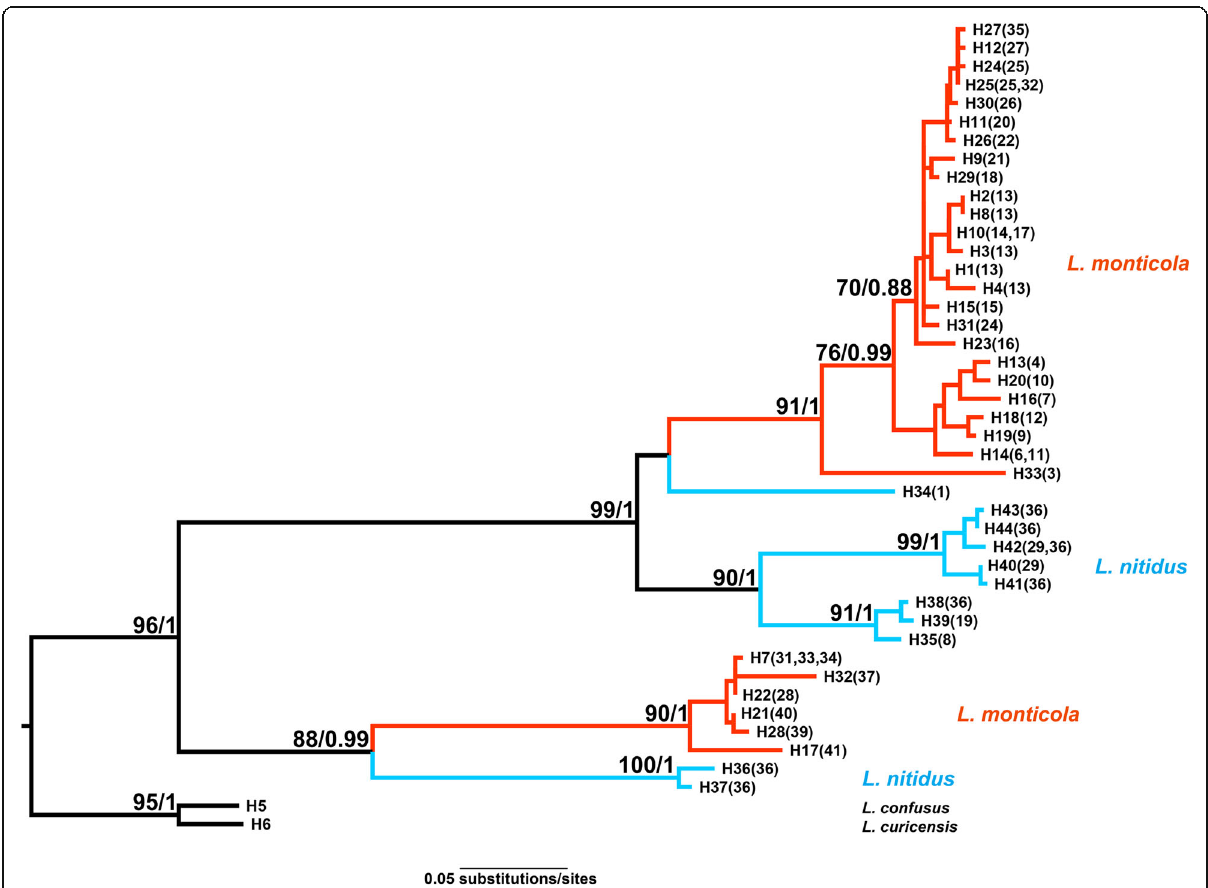
Fig. 4 Maximum likelihood tree for the focal species L. monticola. Maximum likelihood tree based on cytochrome b gene for the focal species L. monticola . Numbers on the branches indicate bootstrap values for maximum likelihood and posterior probabilities for Bayesian inference. Colors of the branches represent L. monticola (in orange ) and L. nitidus (in light blue )